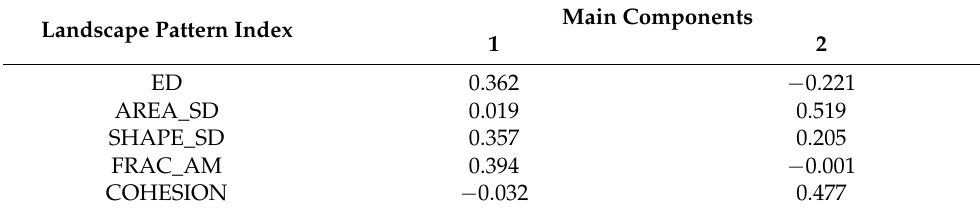
Table 6. Score matrix for each Landscape Pattern Index